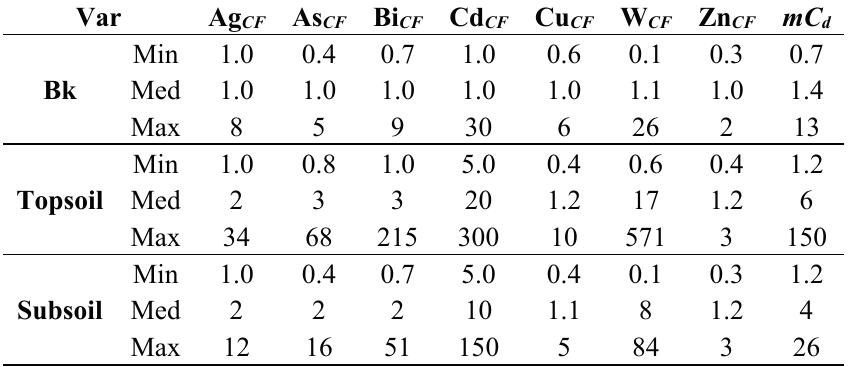
Table 8. Contamination Factors ( CF ) and Modified Degree of Contamination ( mC d ) using geochemical background values. Casegas area is considered as representative of geochemical